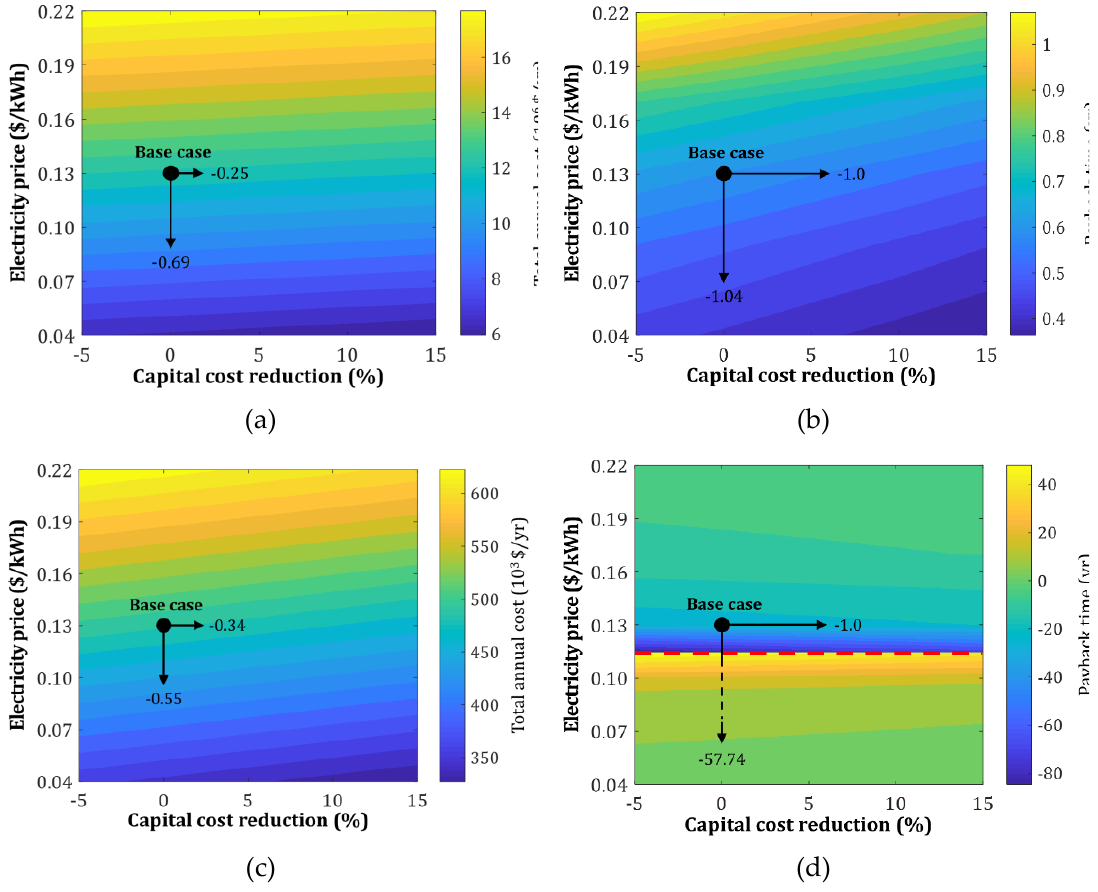
Figure 6. Sensitivity of the total annual cost and payback time to economic parameters: ( a , b ) Heat pump-assisted C4 splitter and ( c , d ) heat pump-assisted de-propanizer. The numbers represent the total annual cost variation (%) or payback time variation (%) due to a 1% change in a